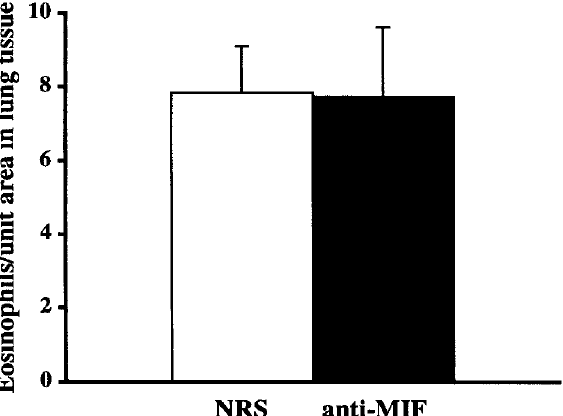
FIG. 1. Effect of anti-MIF treatment on allergen-induced lung tissue eosinophilia. Mice were immunized and then chal- lenged daily with aerosolized OVA. Data are from two independent experiments and are presented as mean ± SEM. NRS = NRS-treated mice ( n =20), anti-MIF = anti-MIF-treated mice ( n =20). Lung tissue eosinophilia did not differ sig- nificantly between anti-MIF-treated and NRS-treated mice.